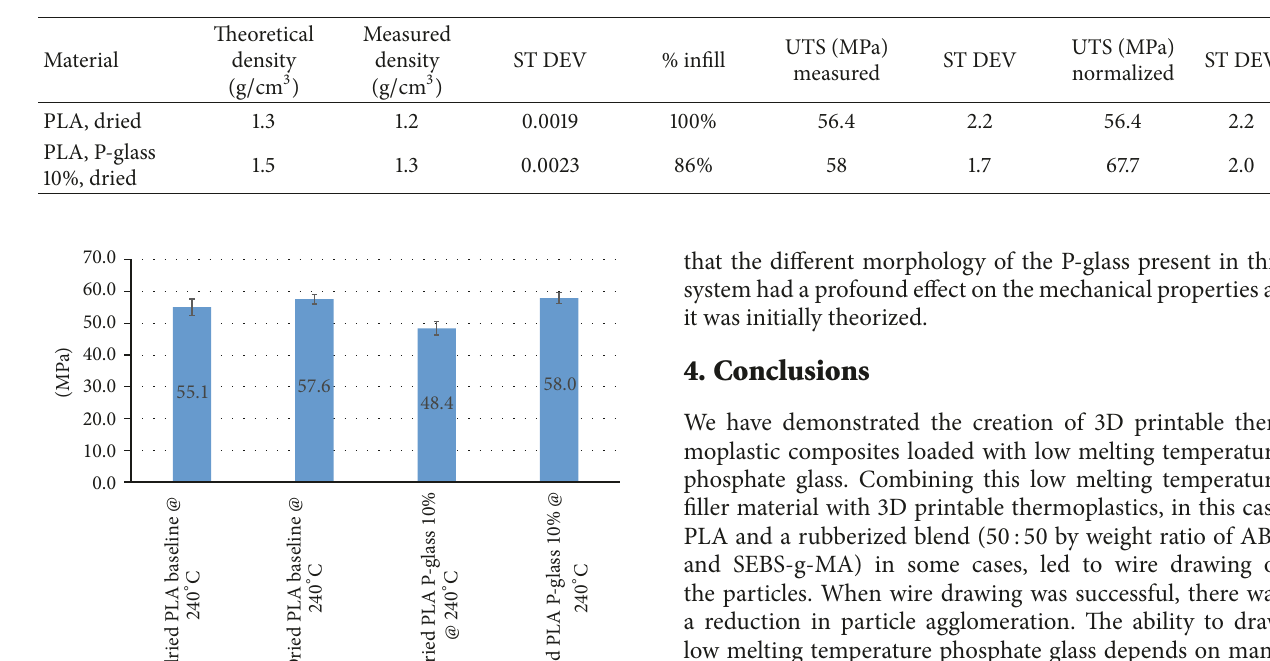
Table 10: Normalization of UTS values for dried PLA printed at 240 ∘ C.